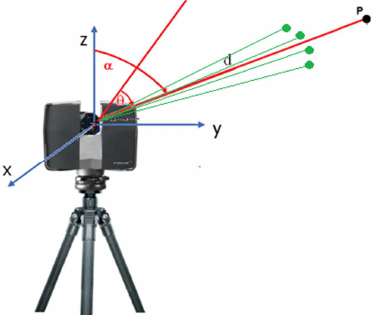
Figure 6. Ray-tracing labelling principle: point P is marked as occluded because its nearest neighbour points (green points) have a shorter distance from scanner.